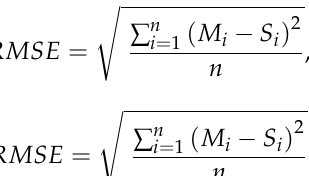
Figure 3. A cross-section and a plan of the 10th floor.